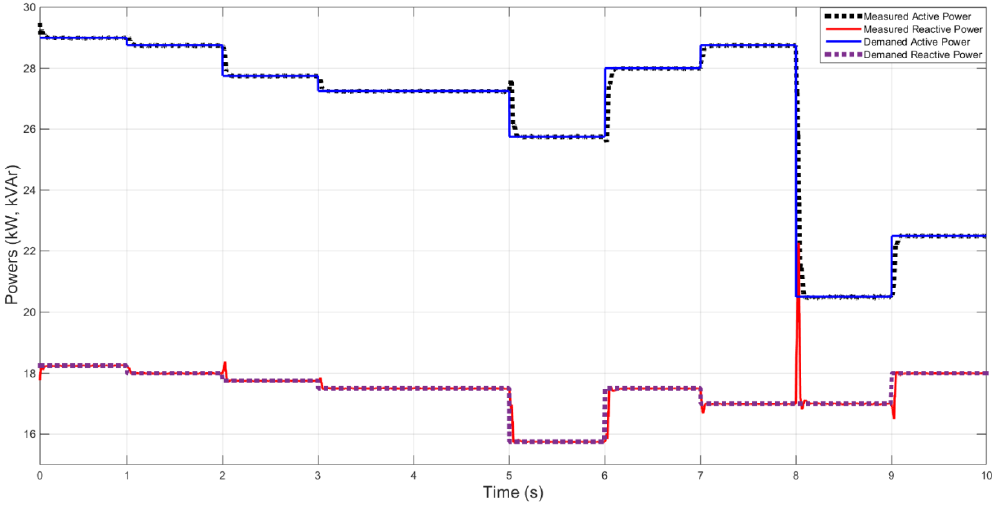
Figure 9. The load demand values and power values drawn from the GEV.